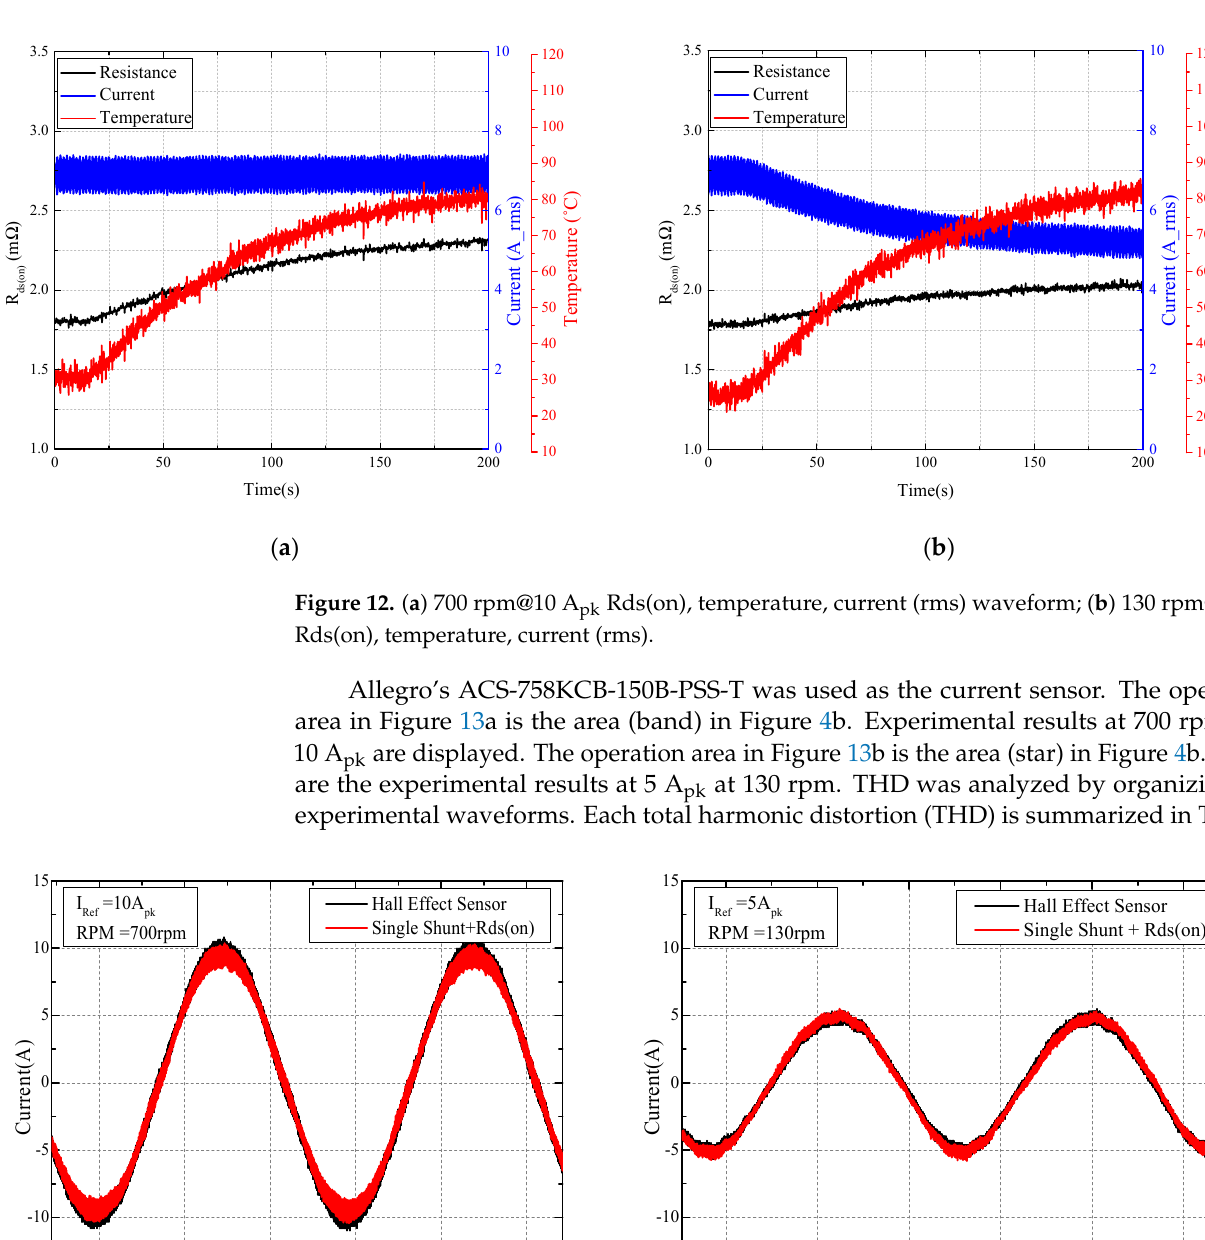
Figure 13. ( a ) 700 rpm@10 A pk Hall-effect sensor vs. single shunt + Rds(on) control current wave-